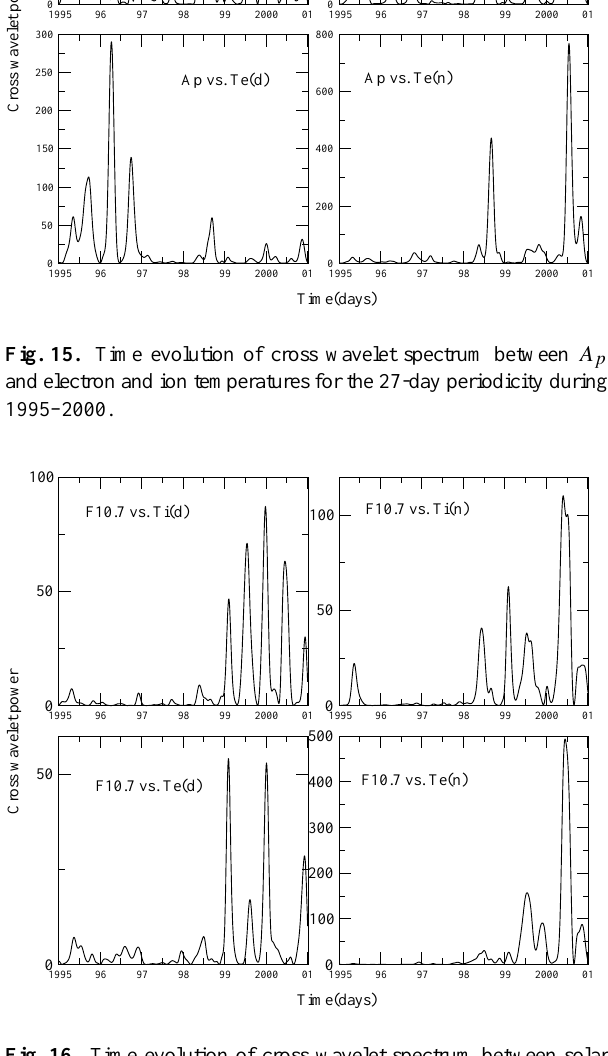
Fig. 16. Time evolution of cross wavelet spectrum between solar radio flux and electron and ion temperatures for the 27-day period- icity during